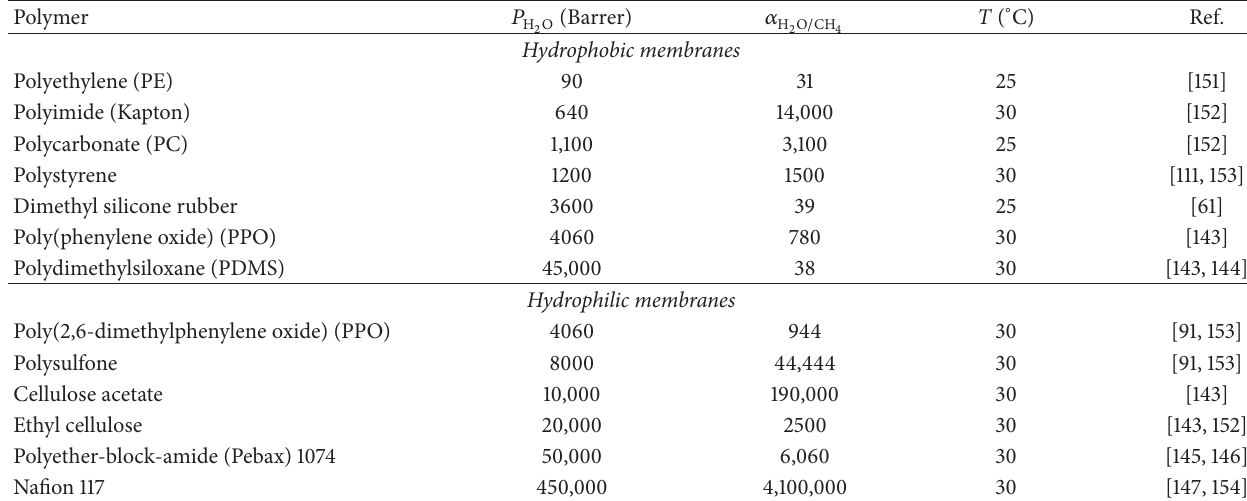
Table 11: Water permeability of hydrophilic and hydrophobic